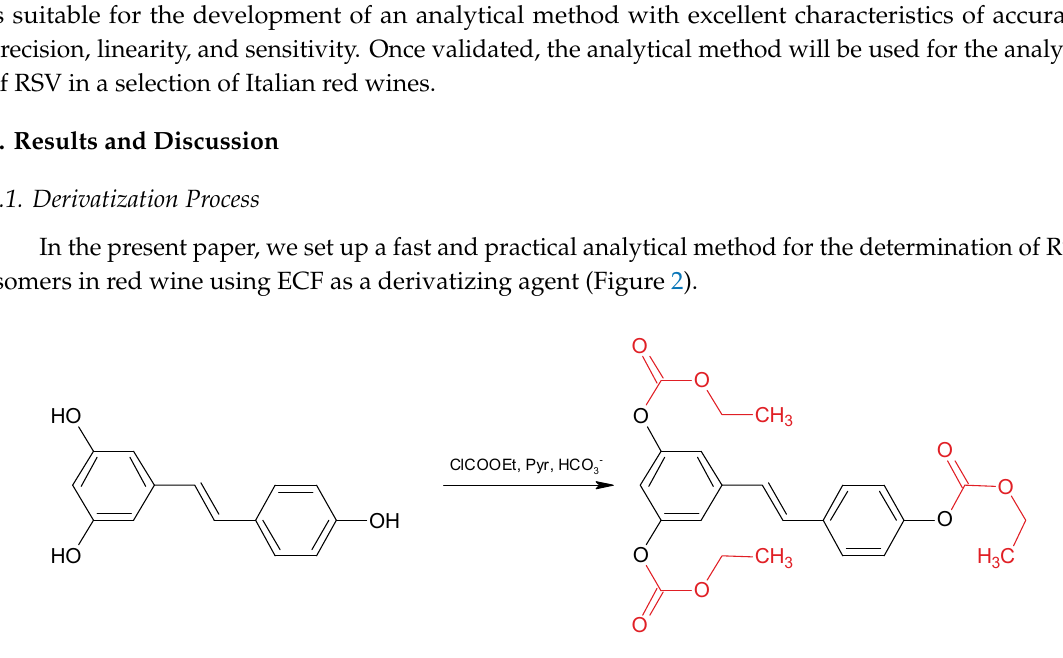
Figure 2. Resveratrol derivatization with ethylchloroformate.